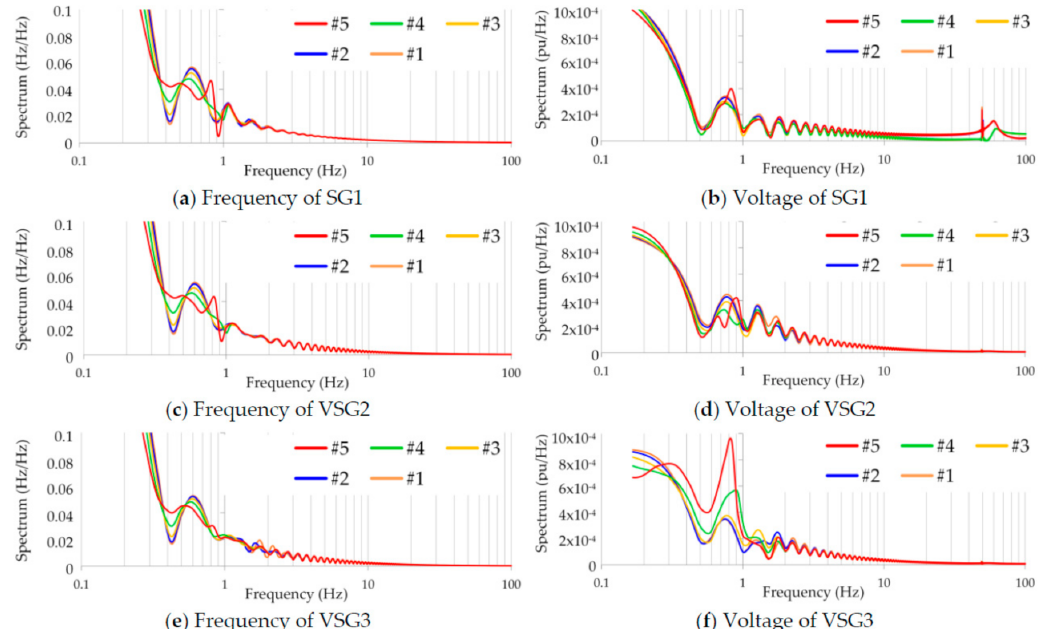
Figure 8. DFT analysis of the system frequency/voltage for tests 1–5 in Table